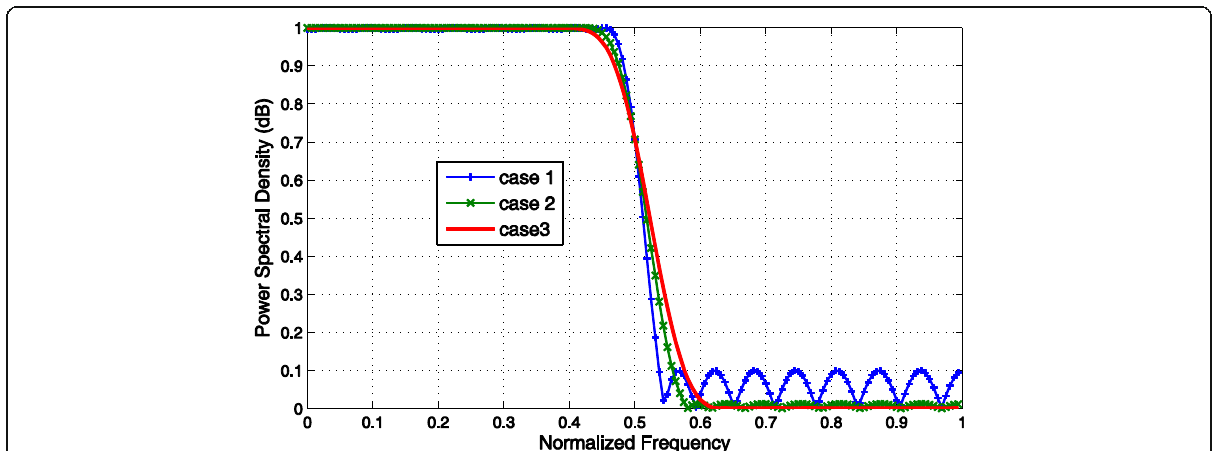
Fig. 4 Frequency responses of 32-tap prototype